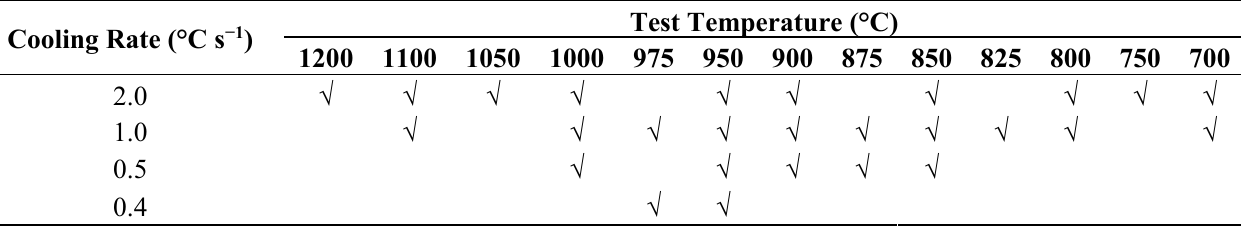
Table 1. Hot tensile test